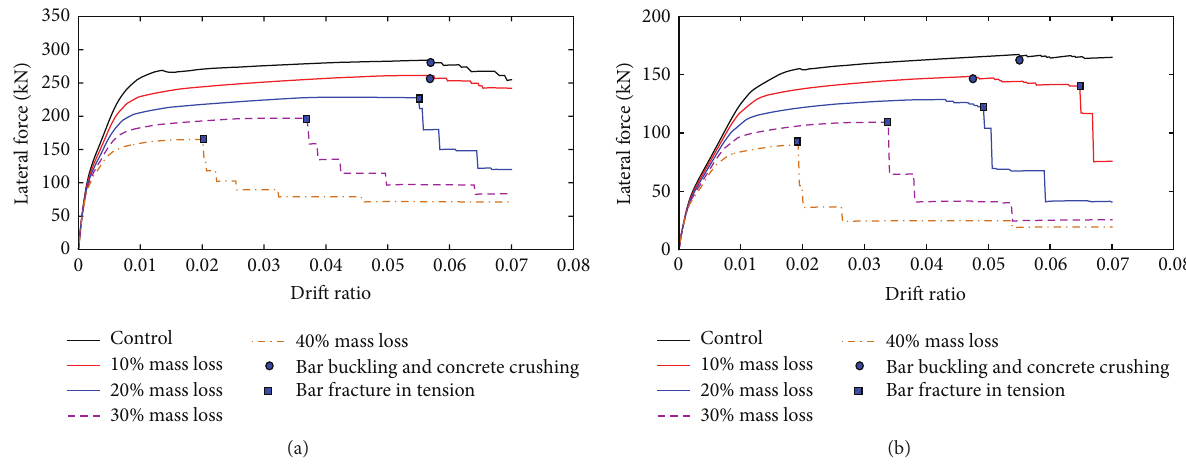
Figure 11: Pushover analyses considering corrosion induced damage in reinforcing steel and cracked cover concrete: (a) Lehman’s column 415; (b) Moyer and Kowalsky’s column